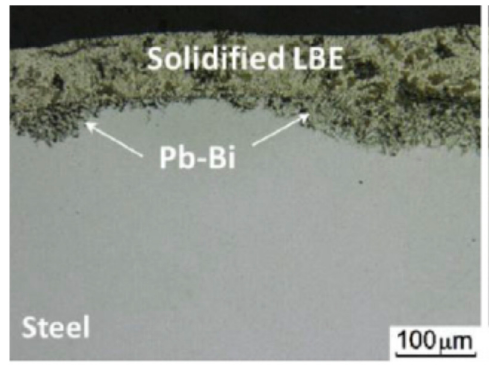
Figure 3. SEM cross-section image showing ferritic zones in stainless steel sample after 3045 h at 500 °C in 10 − 8 wt.% oxygen LBE, from [29]. L 1 , L 2 and L 3 are the length of the ferritic layer.